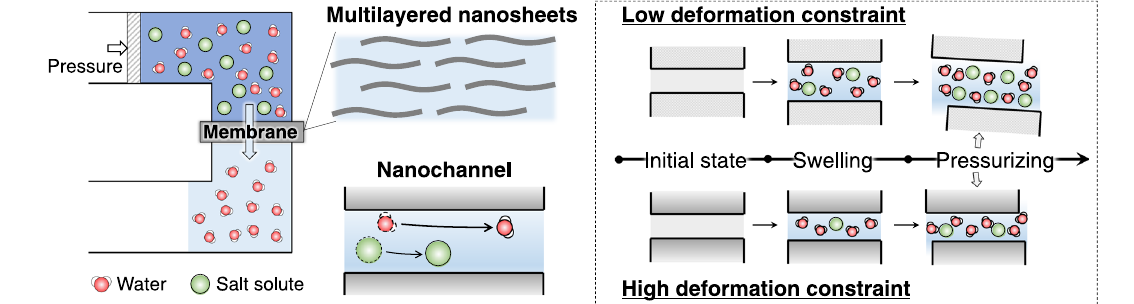
Fig. 1 | Illustrations of reverse osmosis system, multilayered nanosheet mem- brane,andinterlayerednanochannels. Duringreverseosmosis,externalpressure is applied to force water molecules through a semipermeable membrane.